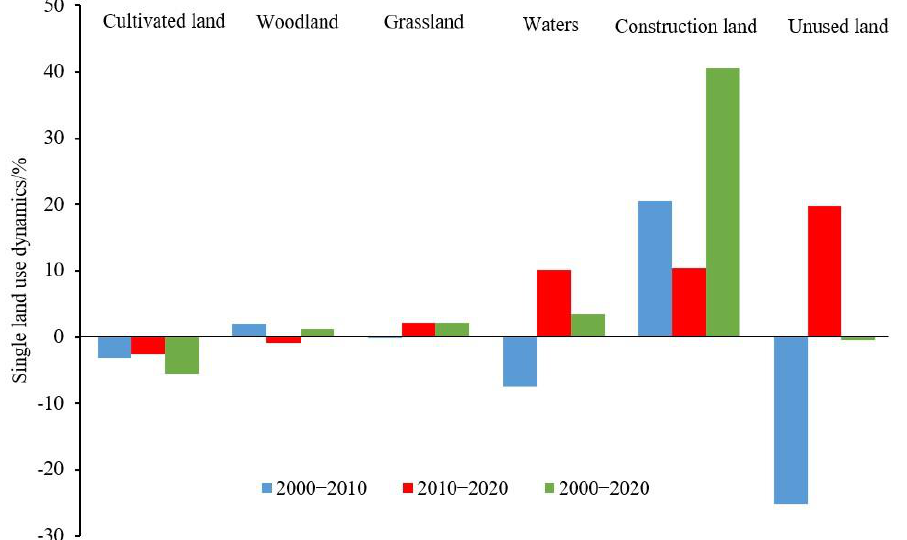
Figure 3. Dynamic degree change of single land use in Guanzhong Plain urban agglomeration from 2000 to 2020.